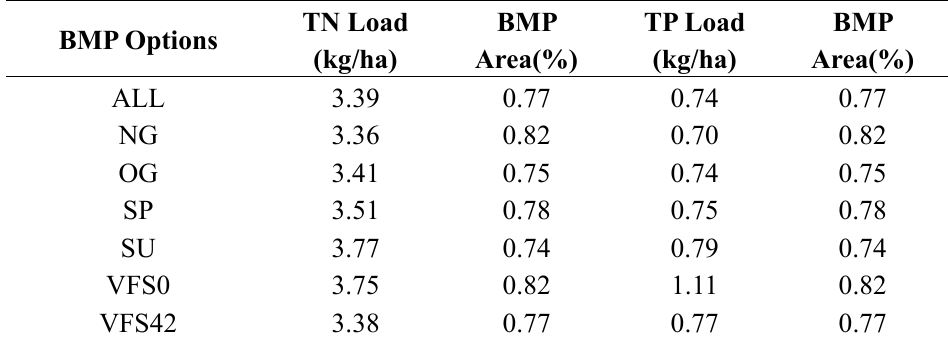
Table 2. Solutions which are medians of the range of pollutant loads and BMP-implemented area for different optimization models.